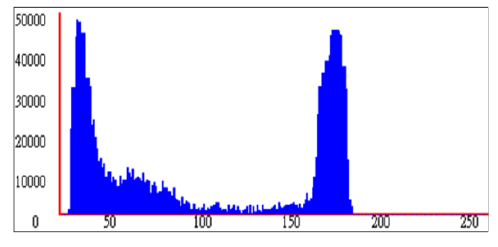
Figure 2. “Gray-scale histogram”.